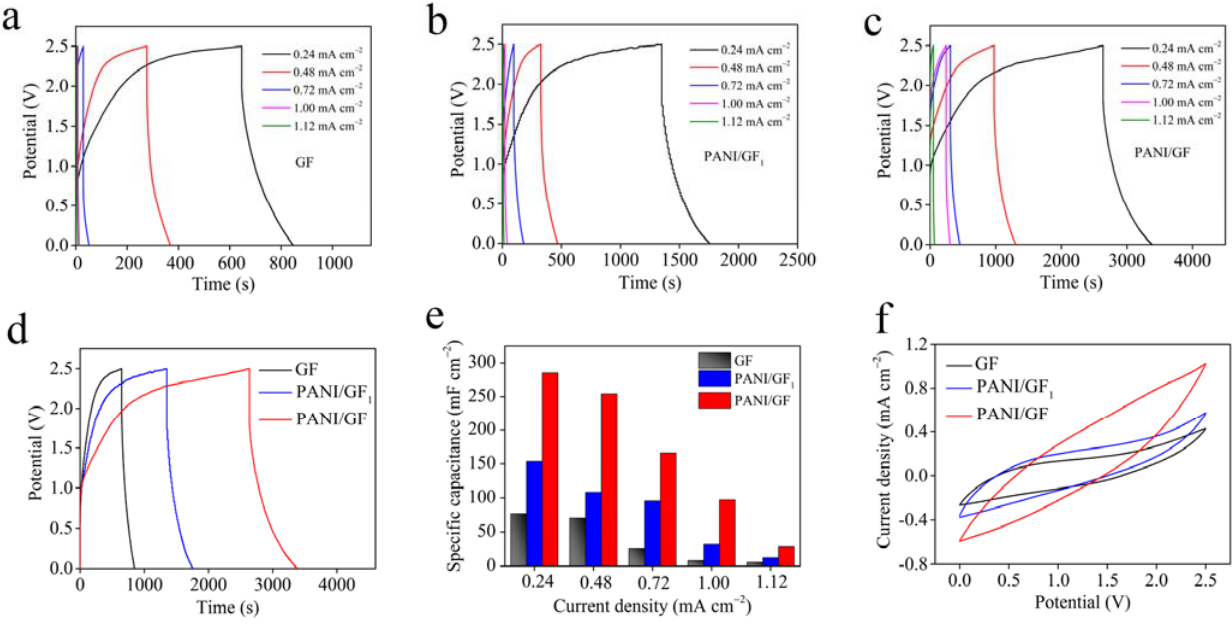
Figure 9. Electrochemical properties of GF, PANI/GF 1 and PANI/GF in EMITFSI/PVDF ‐ HFP gel ‐ electrolyte. ( a – c ) GCD curves of GF, PANI/GF 1 and PANI/GF at various current densities of 0.24, 0.48, 0.72, 1.00 and 1.12 mA cm − 2 ; ( d ) GCD curves of GF, PANI /GF 1 and PANI/GF at 0.24 mA cm − 2 ; ( e ) specific areal capacitances of GF, PANI/GF 1 and PANI/GF at 0.24, 0.48, 0.72, 1.00 and 1.12 mA cm − 2 ; ( f ) CV curves of GF, PANI/GF 1 and PANI/GF at a scan rate of 5 mV s − 1 .